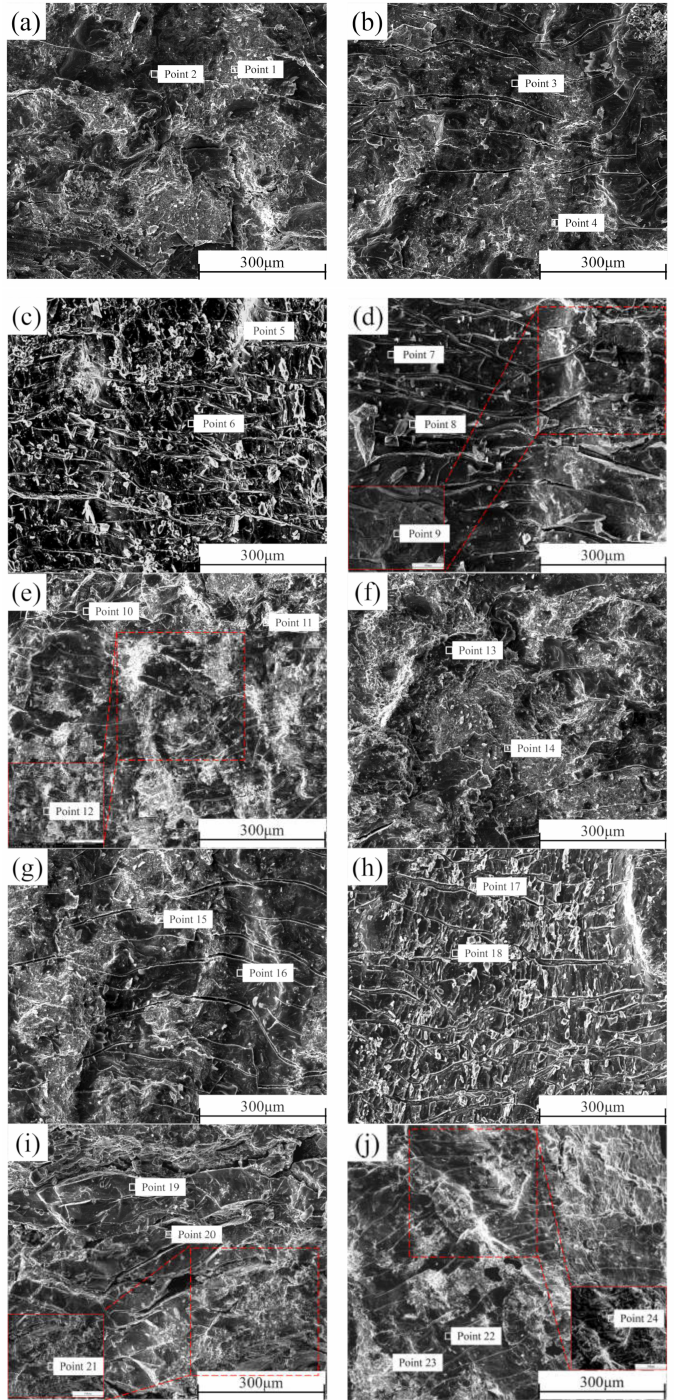
Figure 13. SEM cross-section of the composite plate under different rolling passes: Al side: ( a ) not rolled, ( b ) first pass, ( c ) second pass, ( c ) third pass, ( d ) fourth pass; Mg side: ( f ) not rolled, ( g ) first pass, ( h ) second pass, ( i ) third pass, ( j ) fourth